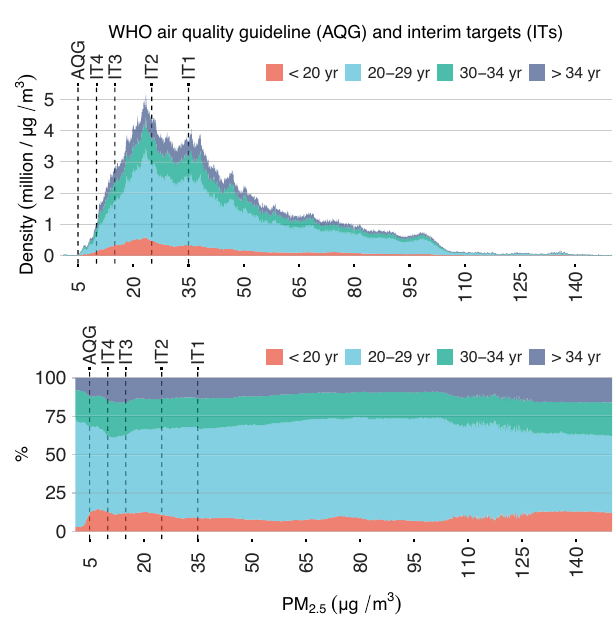
Fig.2|Multipleexposure – responsecurvestolinkPM 2.5 withstillbirth(righty- axis). The all-ages curve and age-speci fi c curves were derived from our self- matched case-control study of stillbirths from 54 countries (left y-axis). The cor- responding PM 2.5 exposures in those countries are shown as boxplots (The centre